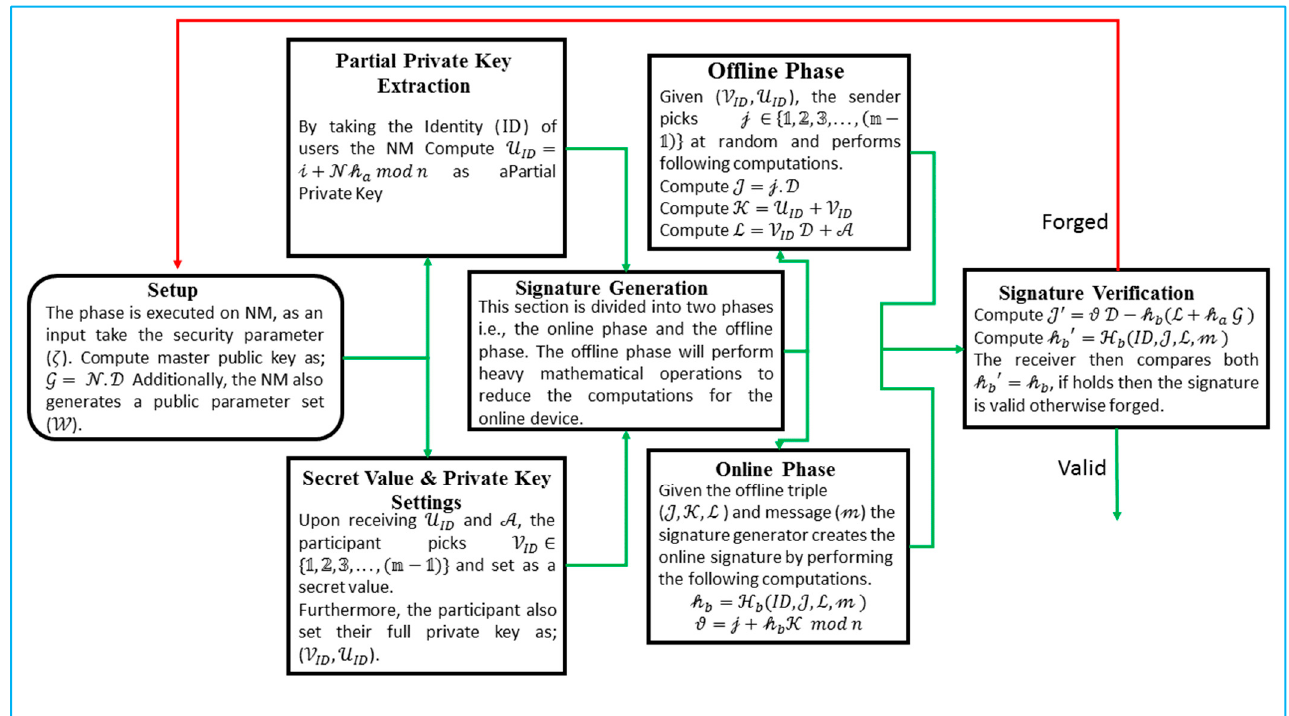
Figure 3. Flowchart of the proposed algorithm.